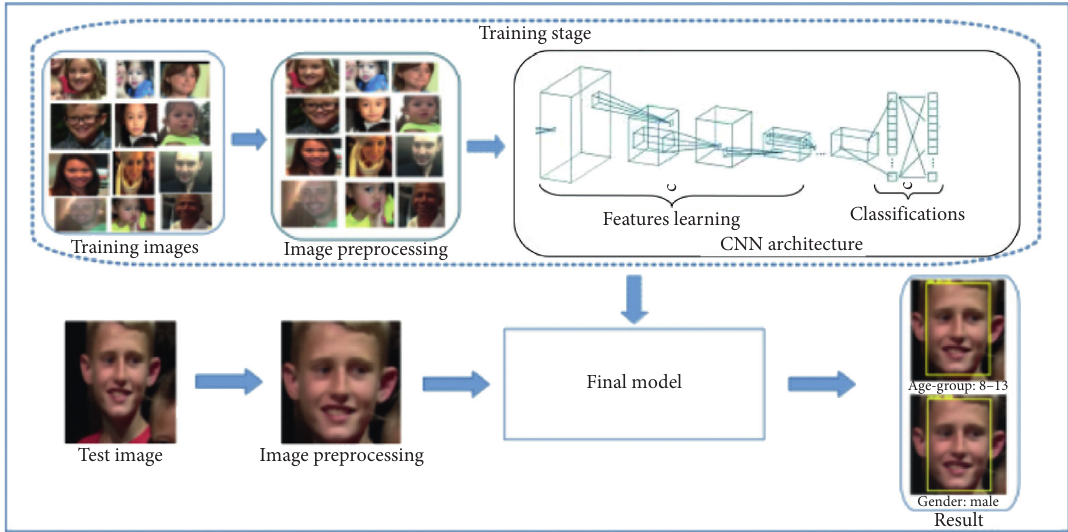
Figure 1: The pipeline of our framework for age group and